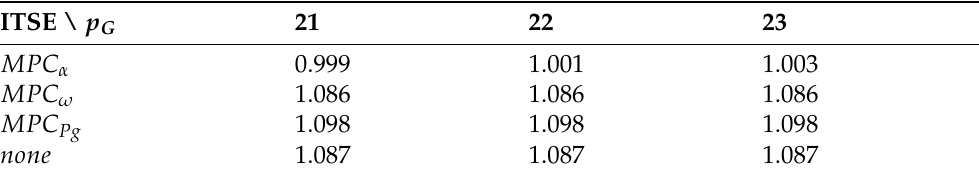
Table 4. MPC Tuning for different auxiliary signal (ITSE) ( × 10 − 3 ).